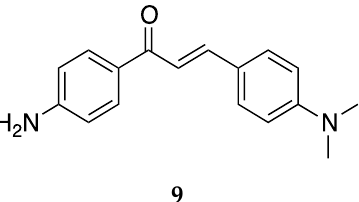
Figure 11. Chemical structures of 4-aminochalcone derivatives with dialkylated amino substitution on ring